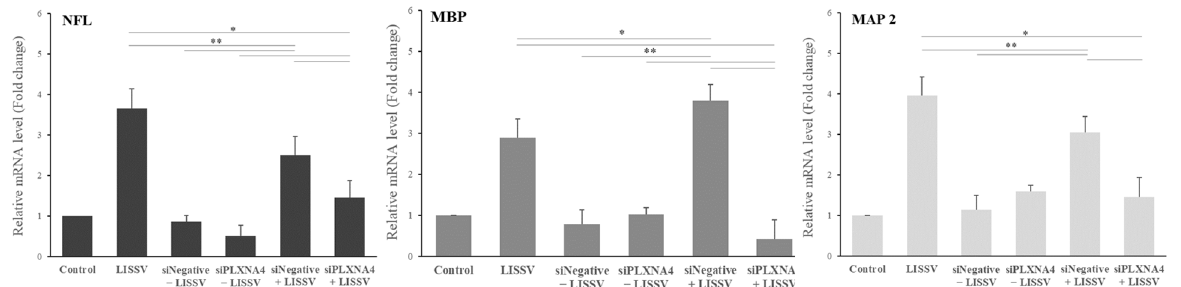
Figure 9. Expression of neuron-associated genes in human umbilical-cord-derived mesenchymal stem cells after siPLXNA4 duplex transfection using real-time polymerase chain reaction analysis. Cells were harvested 4 days after low-intensity sub-sonic vibration treatment. NF-L: Neurofilament-L, MBP: Myelin basic protein, MAP2: Microtubule-associated protein 2. Column heights correspond to mean values and error bars to standard deviations ( n = 3). * p < 0.05, ** p < 0.01.